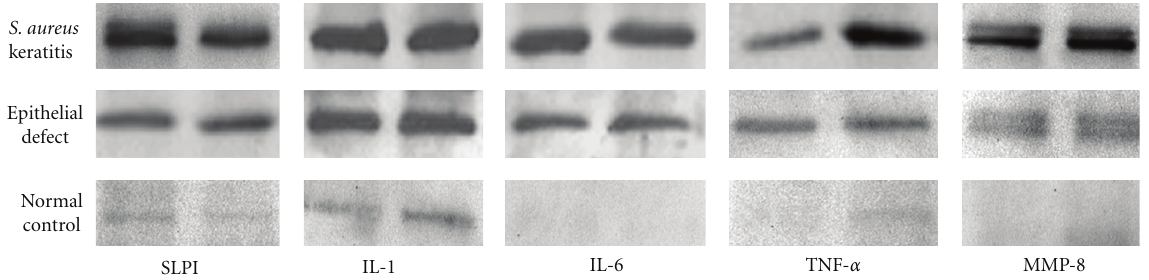
Figure 3: Expression of SLPI, IL-1, IL-6, TNF- α , and MMP-8 in S . aureus , epithelial defect, and control groups. After 48 hours, corneas were dissected and homogenized, and protein levels were examined by Western blot. Bands represent duplicate experiments with similar results.